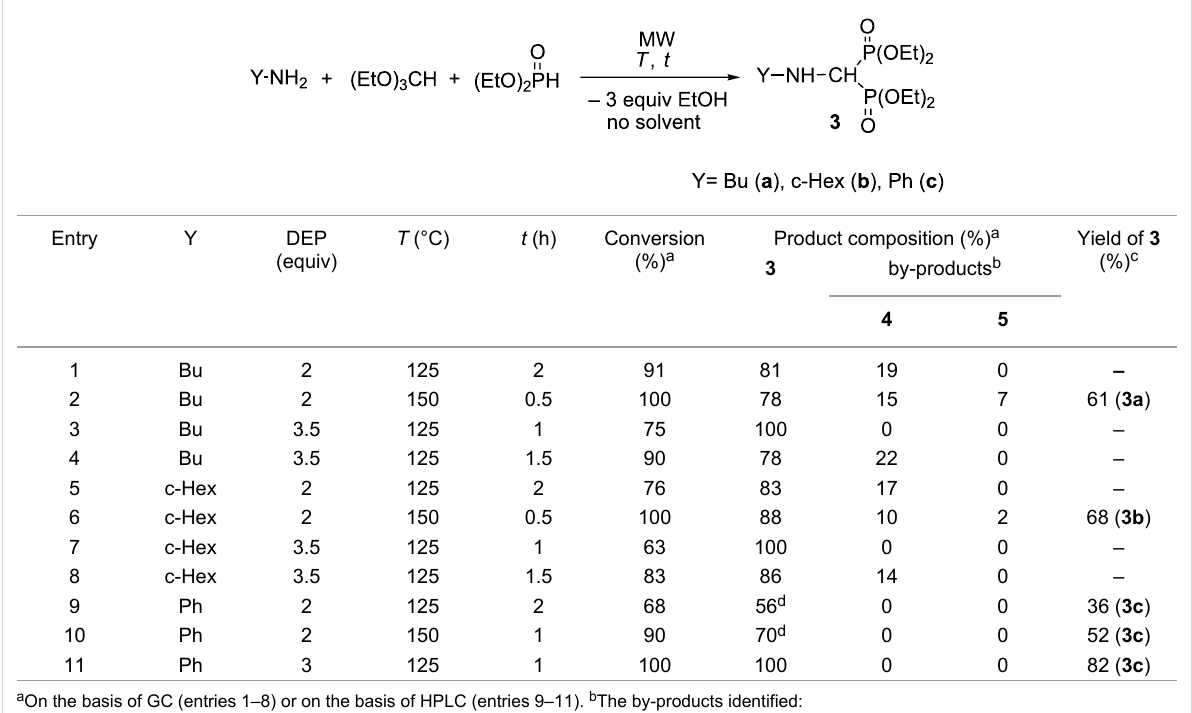
Table 3: The reactions of primary amines with triethyl orthoformate and diethyl phosphite.